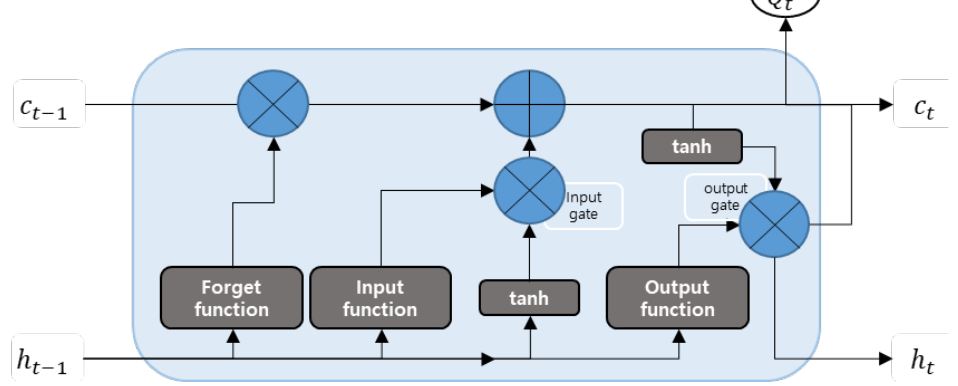
Figure 4. Conceptual diagram of the LSTM